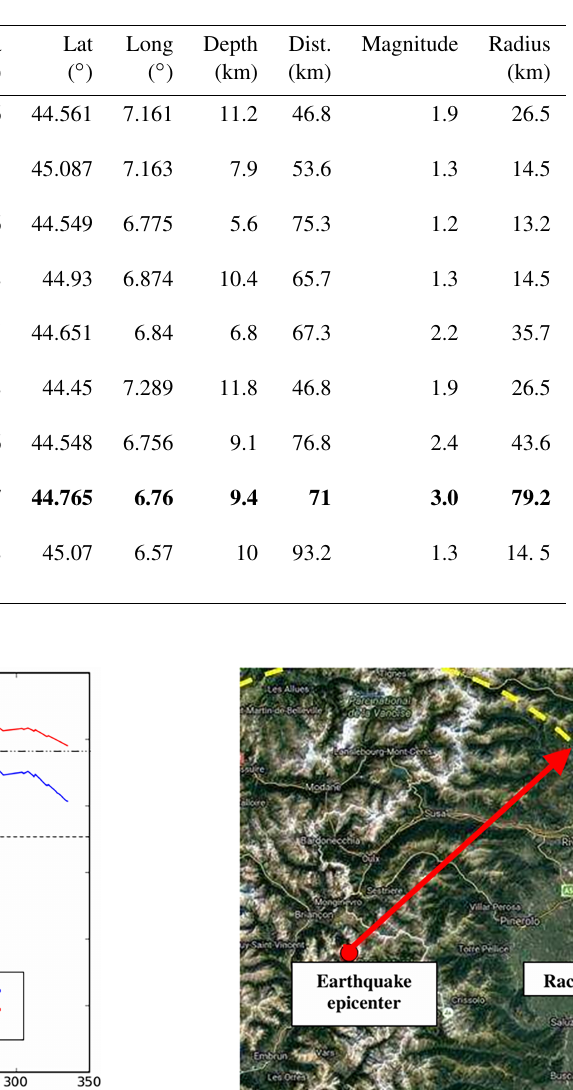
Table 1. List of nearby earthquakes that occurred during the AE monitoring; the event with the preparation zone encircling the monitoring site is written in bold.